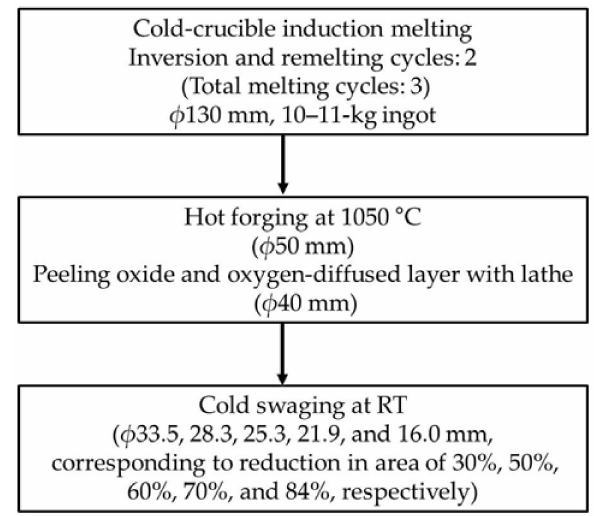
Figure 1. Processing history of the Zr–1Mo alloy used in this